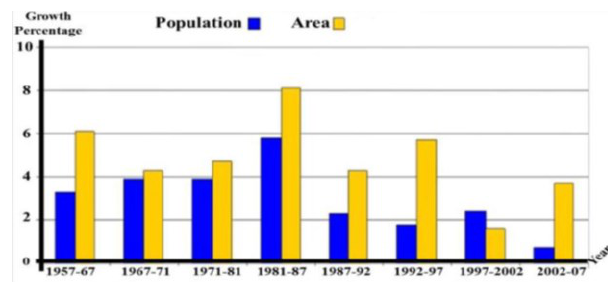
Figure 28. Comparing Population Growth with Area Growth of Tabriz (Kheyroddin, et.al,